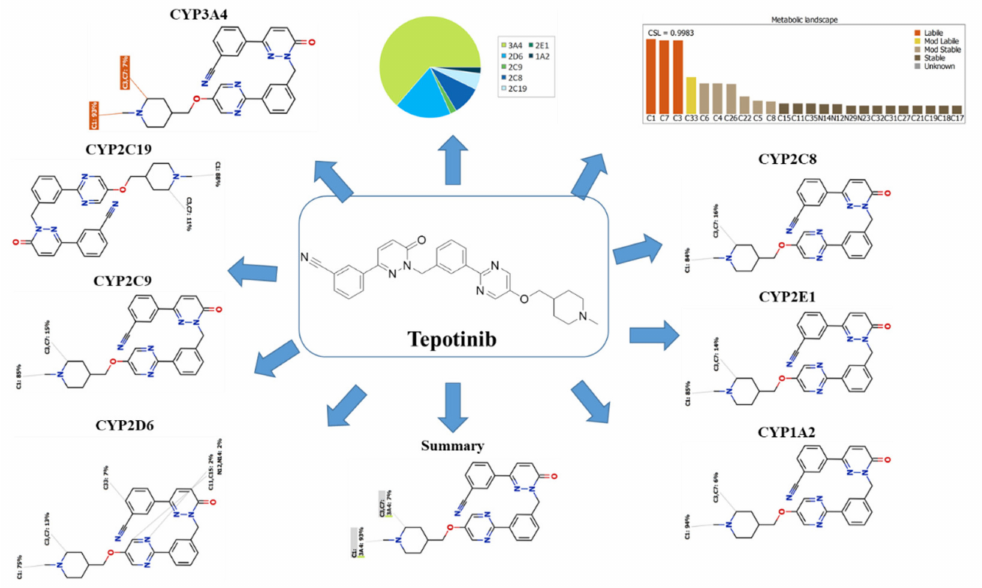
Figure 1. Predicted metabolic sites for tepotinib (TEP) by WhichP450 ™ module of StarDrop